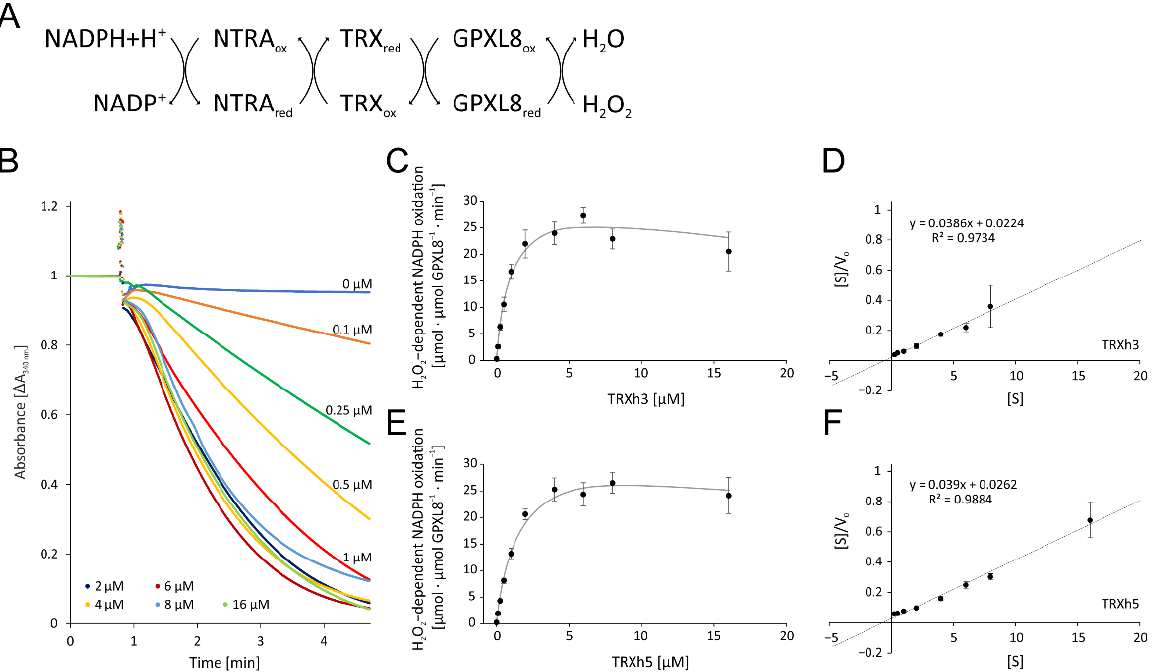
Figure 5. Optimization of the glutathione peroxidase-dependent H 2 O 2 detoxification assay . ( A ) Scheme of the reaction sequence. ( B ) Representative spectrophotometric recordings adjusted to identical time point of H 2 O 2 addition and similar baselines of TRXh3 concentration-dependent reduction of H 2 O 2 by 3 µ M GPXL8. The assay contained 1 µ M NTRA, 200 µ M NADPH, 300 µ M H 2 O 2 and variable TRXh3 concentrations as indicated. The initial linear rate was used for quantification. ( C ) TRXh3 concentration dependency. ( D ) Hanes–Woolf plot of GPXL8 and 0.25–8 µ M TRXh3 as electron donor according to ( C ). ( E ) TRXh5 concentration dependency. ( F ) Hanes–Woolf plot of GPXL8 and 0.25–16 µ M TRXh5 as electron donor according to ( E ). Data are means ± SD of n ≥ 6 ( C – F